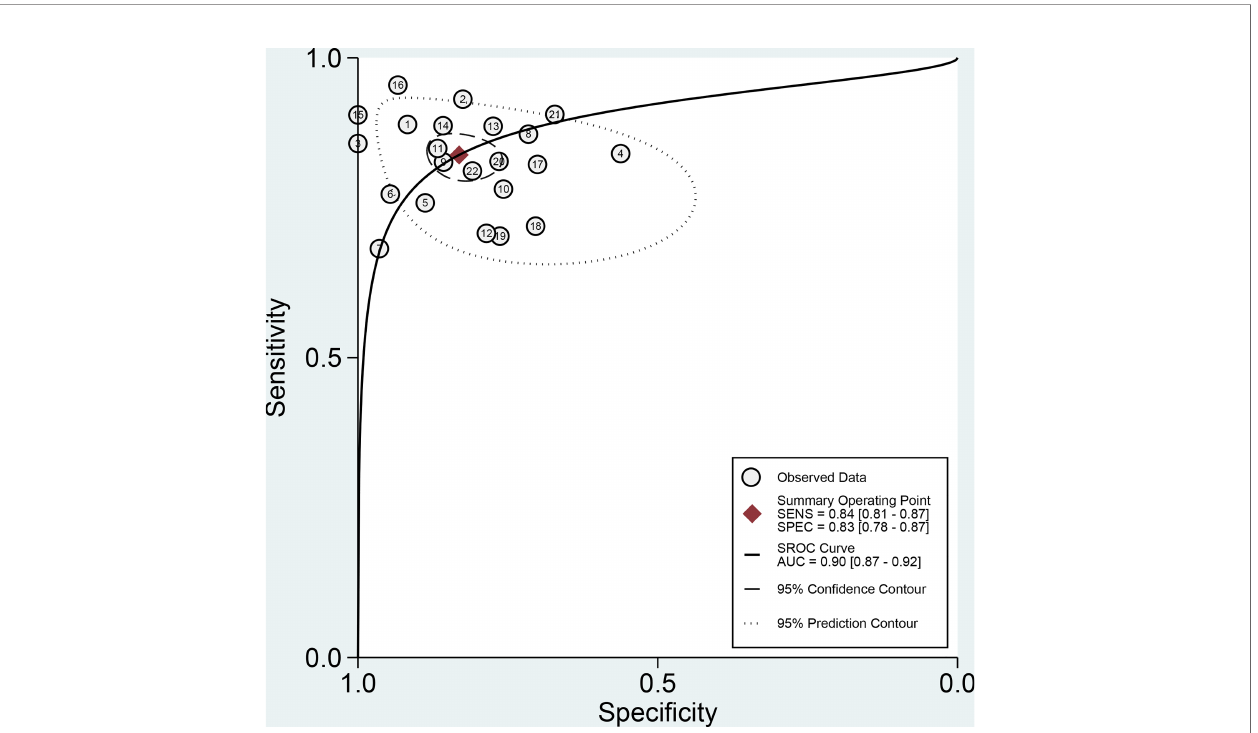
FIGURE 5 | Summary receiver operating characteristic (SROC) plots of radiomics for the preoperative identi fi cation of microvascular invasion in hepatocellular carcinoma. Each circle indicates one included study. Values in brackets are 95% CIs. AUC, area under the receiver operating characteristic curve.